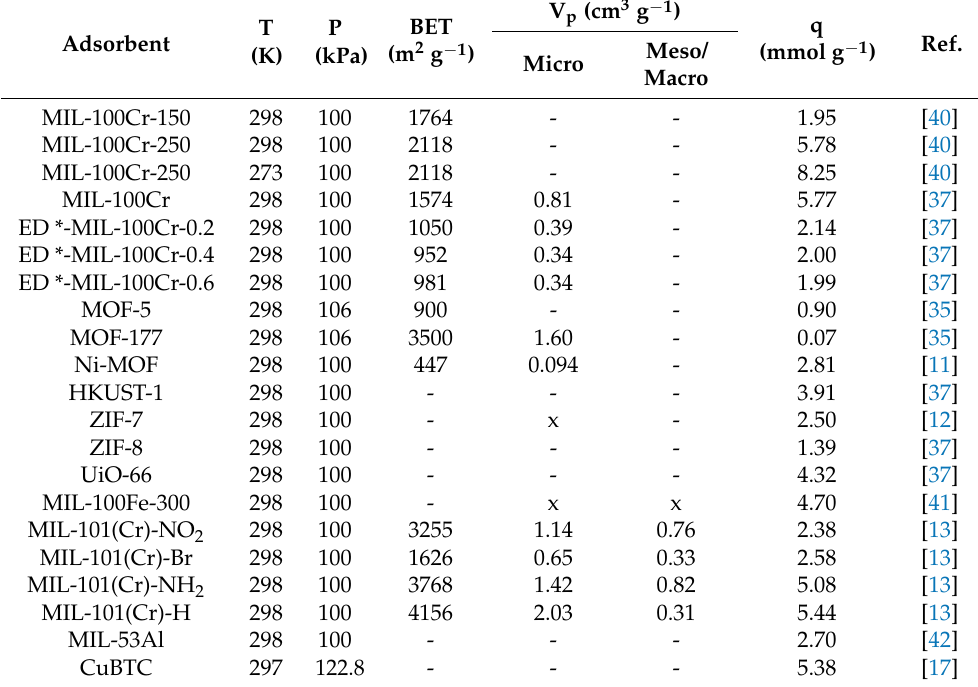
Table 5. MOFs based materials in N 2 O adsorption